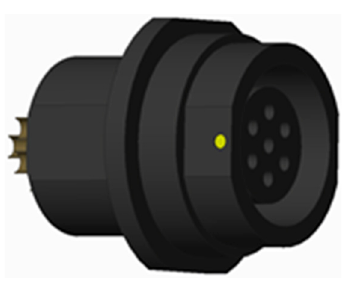
Figure 8. Watertight connector.